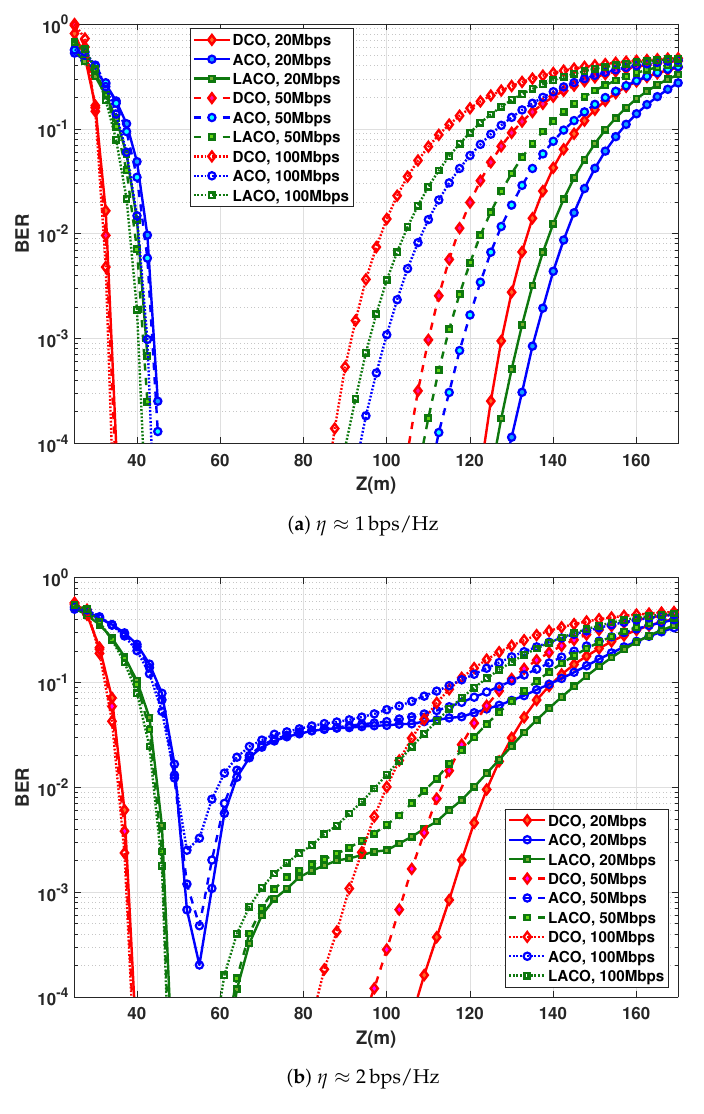
Figure 12. BER performance as a function of distance using 100 LEDs with P Tx,e = 50mW for each; N = 1024. ( a ) η ≈ 1bps/Hz (e.g., DCO-OFDM with 4-QAM) with N CP = 9, 20, and 28, for R b = 20, 50, and 100Mbps, respectively; ( b ) η ≈ 2bps/Hz (e.g., DCO-OFDM with 16-QAM) with N CP = 5, 11, and 20, for R b = 20, 50, and 100Mbps,